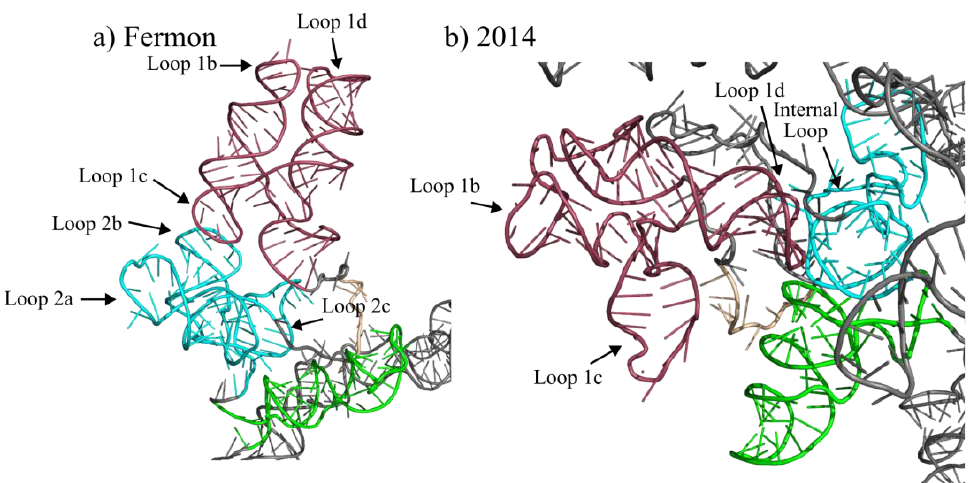
Figure 4. Secondary structure of domains I and II of EV-D68 5 ′ UTRs. ( a ) and ( b ) represent domains I and II of the 5 ′ UTR of the Fermon and 2014 strains of EV-D68, respectively. The shape reactivity of each nucleotide is indicated by colored shading. Grey shading indicates little reactivity, with re- activity values below 0.40. Orange shading indicates moderate reactivity, with reactivity values be- tween 0.40 and 0.85. Red shading indicates high reactivity, with values greater than 0.85.